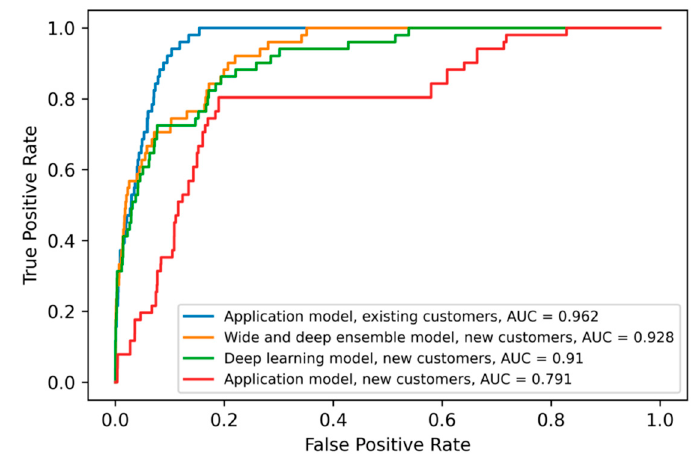
Figure 3. ROC curves, large test sample (2020).